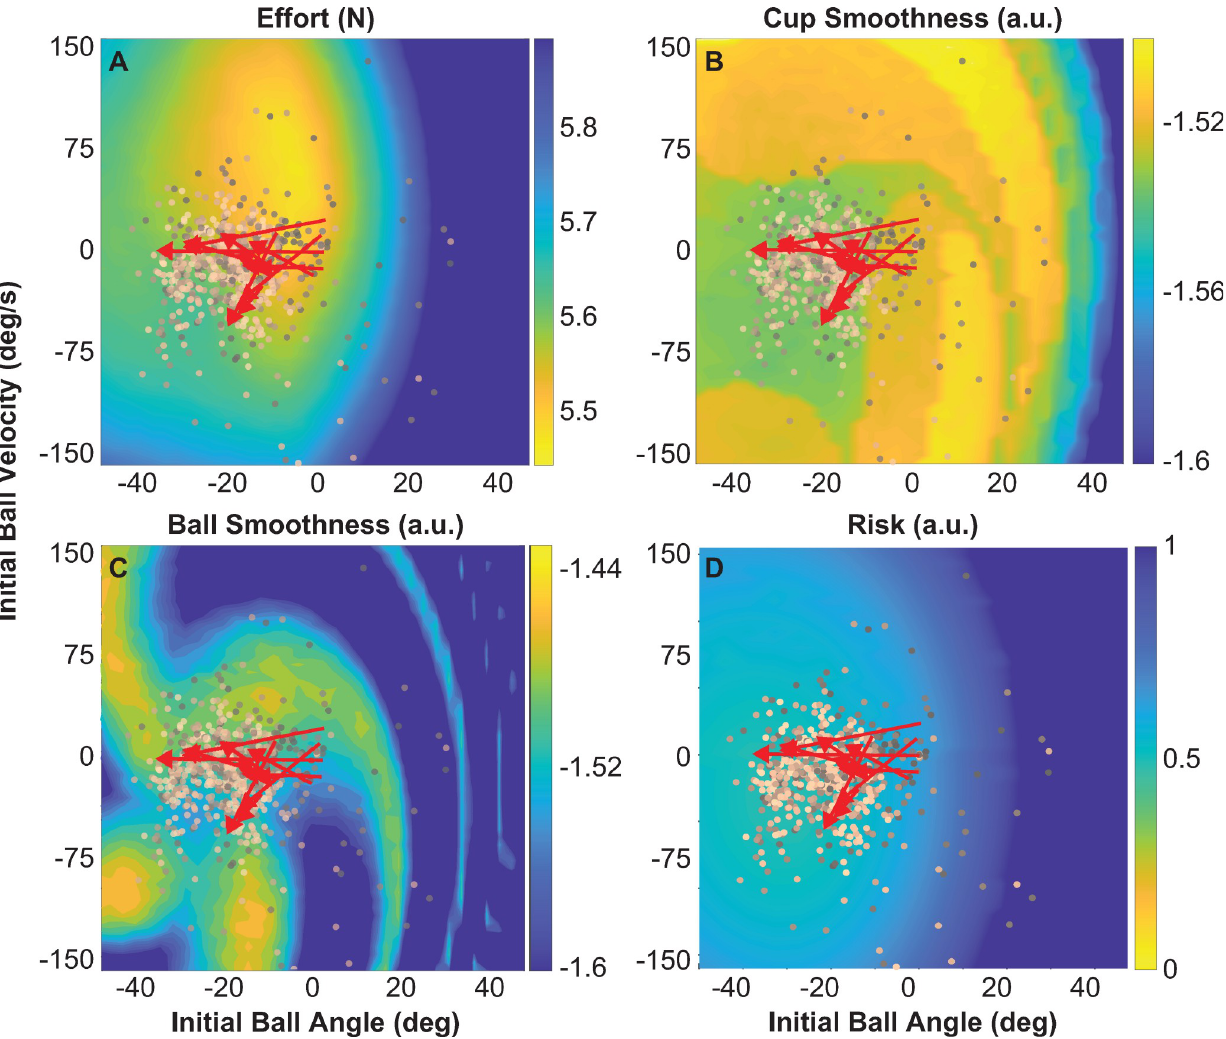
Fig 10. Predicted effect of initial ball states on effort, smoothness and risk metrics: Simulated metrics generated by forward simulations using an impedance controller for different initial ball angles and velocities. The impedance parameters were: K = 40 N/m and B = 40 Ns/m; the cup frequency was fixed at 0.58 Hz for all simulations. In all simulated maps experimental data of ball angles and velocities from all 1100 successful trials are overlaid; darker colors indicate early trials and lighter colors show later trials. For each subject, the means of the first 5 trials and the last 5 trials are connected and shown by red arrows. A. Effort expressed as RMS of F inter ( t ). B. Simulated cup smoothness values calculated for different initial ball angles and initial ball velocities. C. Simulated ball smoothness values calculated for different initial ball angles and initial ball velocities. D. Risk or the inverse of energy margins. In all simulations, yellow indicated the desired